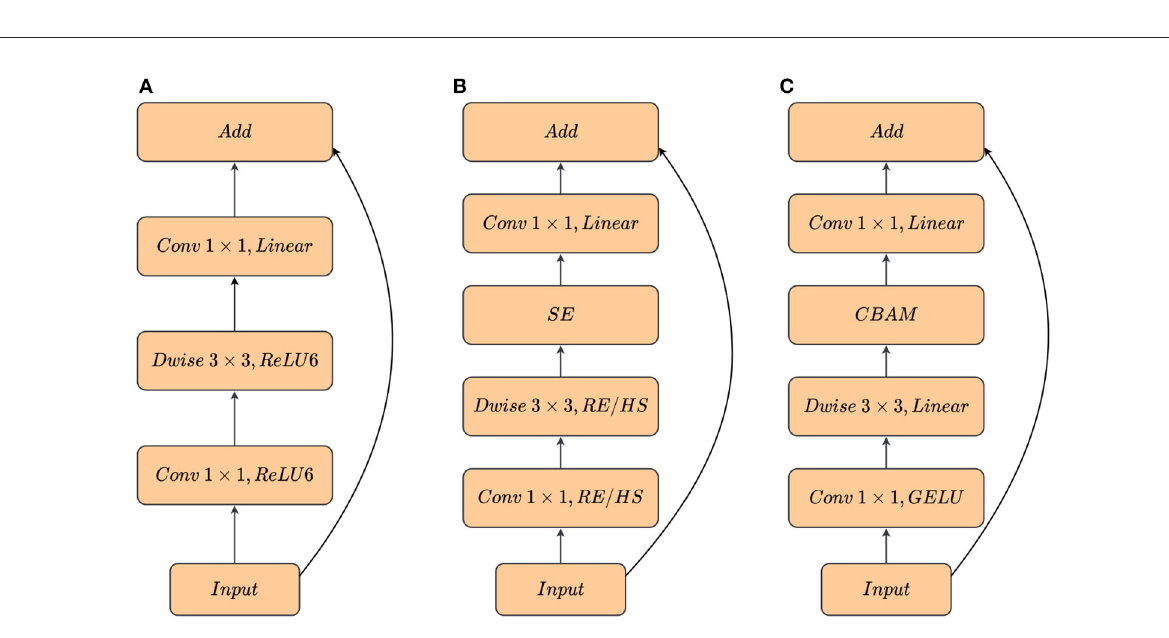
FIGURE5 Comparison of different inverted bottleneck blocks. (A) MobileNetV2 block. (B) MobileNetV3 block. RE/HS denotes ReLU or h-swish. MobileNetV3 uses different activation function at different depths of the network. (C) MBConvA block. RE/HS with GELU is replaced in the first Conv and RE/HS is removed in Dwise. Linear indicates that there is no activation